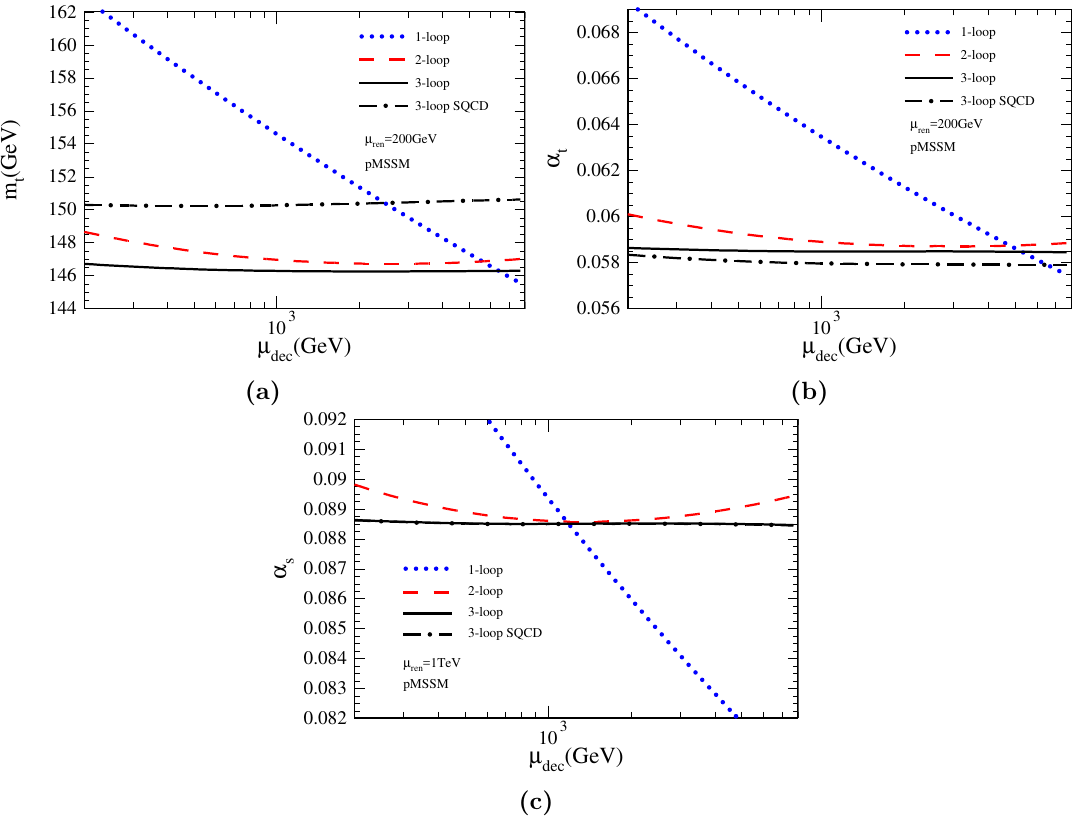
Figure 3. m t ( (cid:22) ren = 200 GeV), (cid:11) t ( (cid:22) ren = 200 GeV), and (cid:11) s ( (cid:22) ren = 1 TeV) as functions of (cid:22) dec . The dotted, dashed and full lines correspond to one-, two- and three-loop running. The dot-dashed lines display the three-loop SUSY-QCD